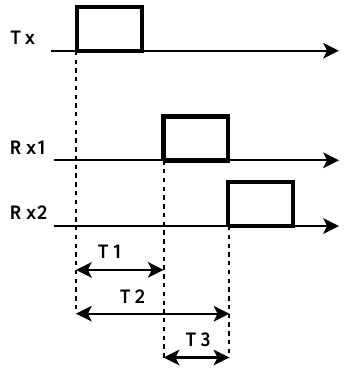
Figure 4. Measuring the Start Frame Delimiter delay with a receiver–receiver